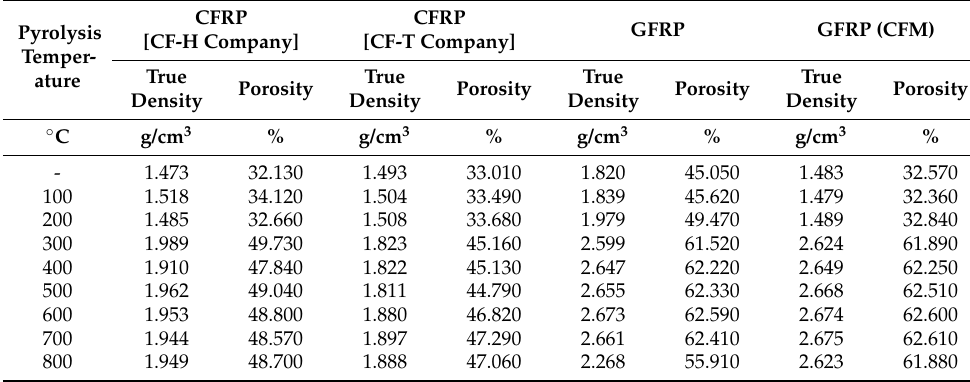
Table 6. True density and porosity of FRP according to pyrolysis temperature.